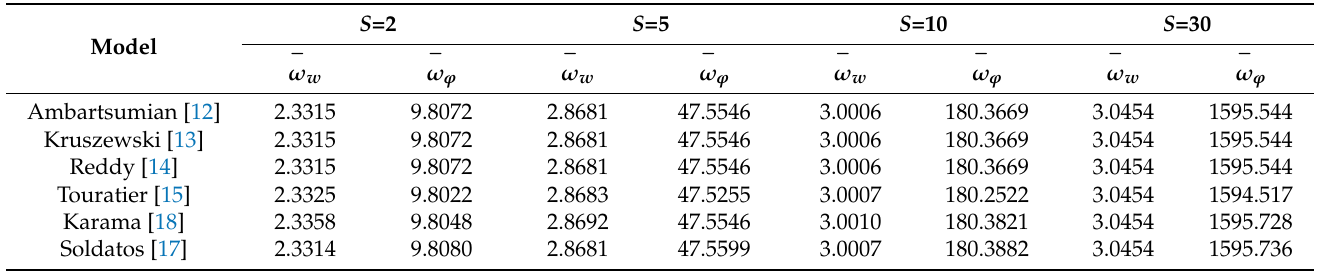
Table 5. Comparison of non-dimensional fundamental ( m = 1 ) flexural and thickness shear mode frequencies of the piezoelectric beam.